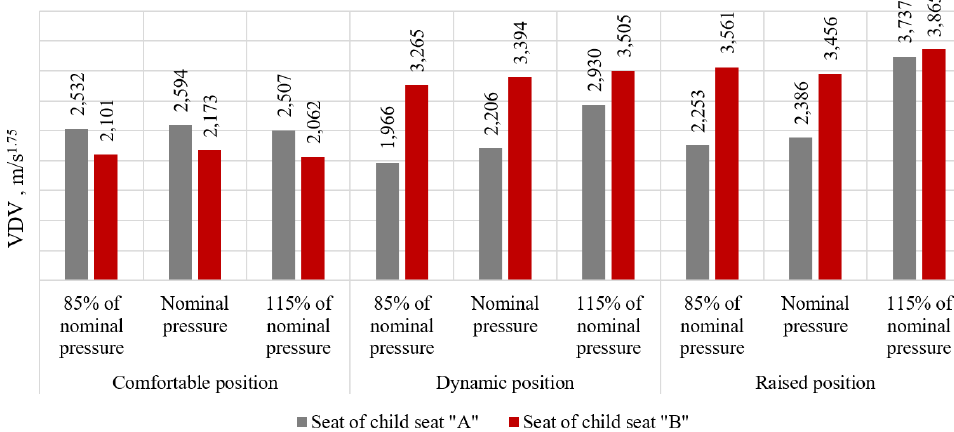
Figure 13: VDV index for the tested seats, loaded with a mass of 7.5 kg during the